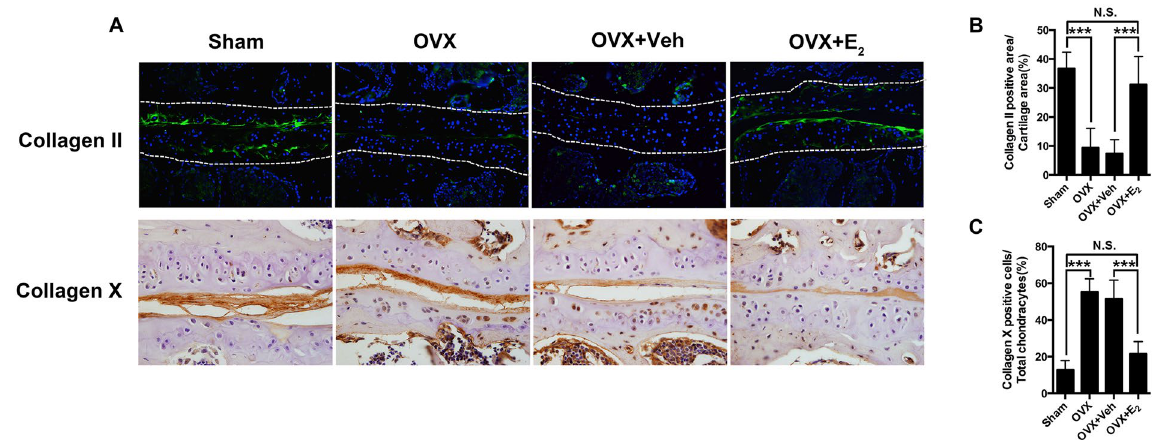
Figure 4. Change of type II and type X collagen expression in ovariectomy-induced LFJ cartilage degeneration. ( A ) Immunofluorescent and immunohistochemistry staining of type II and type X collagen in LFJ cartilage (magnification 600 × ). ( B and C ) Quantitative evaluation of type II collagen-positive areas and type X collagen- positive chondrocytes in LFJ cartilage. Key: *** P < 0.01, (N.S.) not